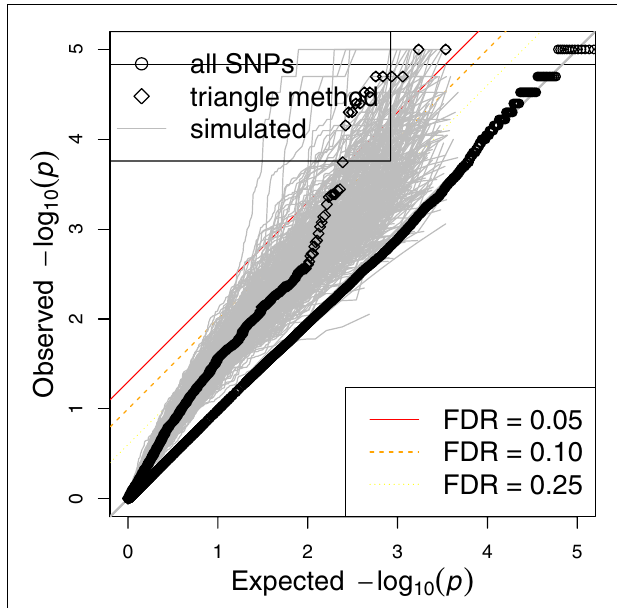
FIGURE 5 | Distribution of p -values for all SNPs and triangle method-derived SNPs from actual phenotype as well as simulated phenotypes. QQ plots are shown for all SNPs as well as the SNPs that come of the triangle method. Gray dots represent the QQ plots for the triangle method-derived SNPs from 1000 simulated phenotypes. Note that the triangle method may yield spurious associations if we rely on the traditional